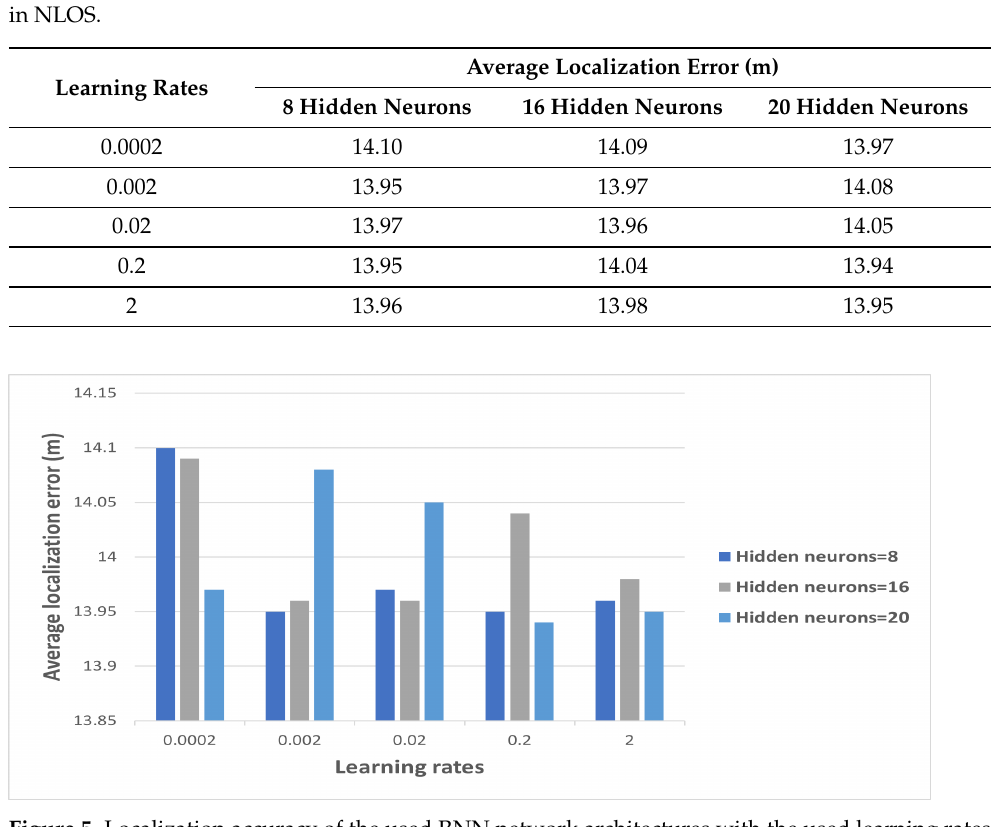
Figure 5. Localization accuracy of the used RNN network architectures with the used learning rates in